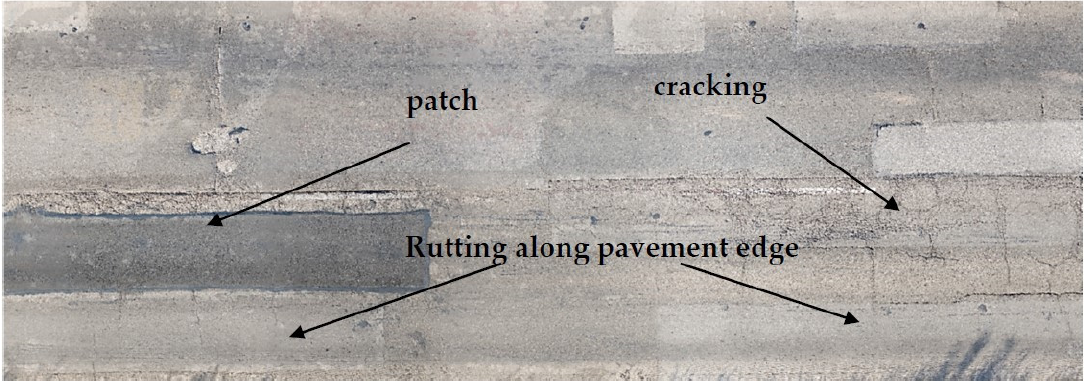
Figure 21. Cropped section from subsection 1.